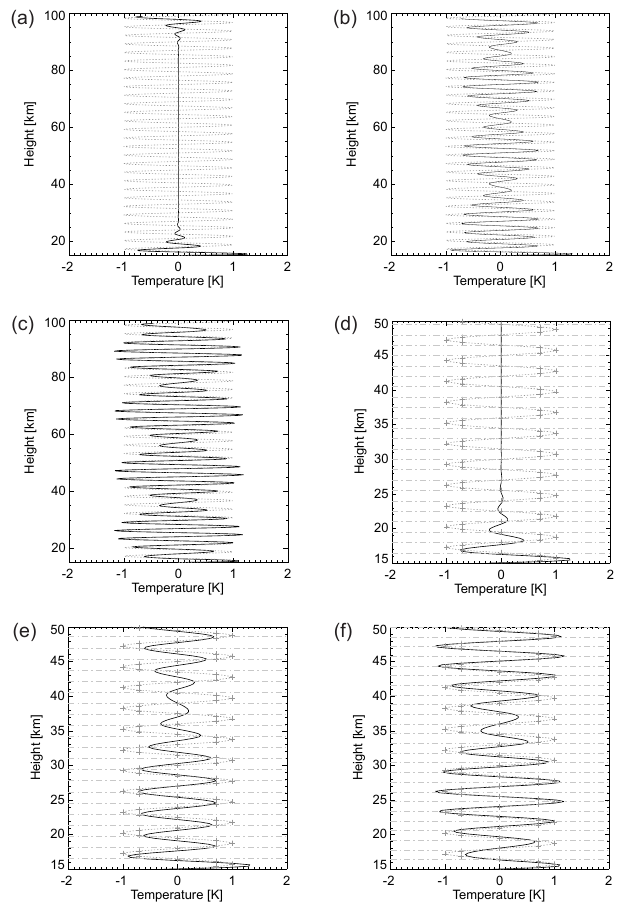
Figure 4. Dependence of the sum of squared residuals on the phase of the wave with a wavelength of 3.0km and a distance of 1.4km (short dashes), 1.5km (solid line) and 1.6km (long dashes) between two spline sampling